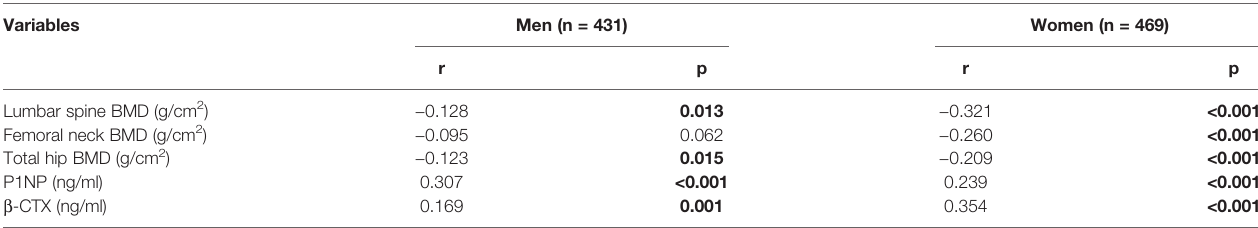
TABLE 3 | Correlations between serum ucOC level with BMD and BTMs. Variables